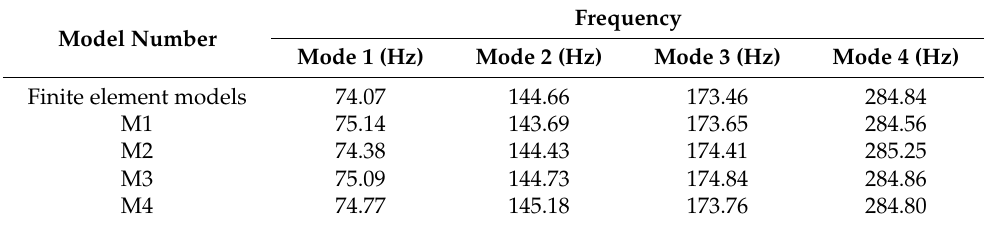
Table 5. Natural frequency comparisons between stiffened plate specimens.